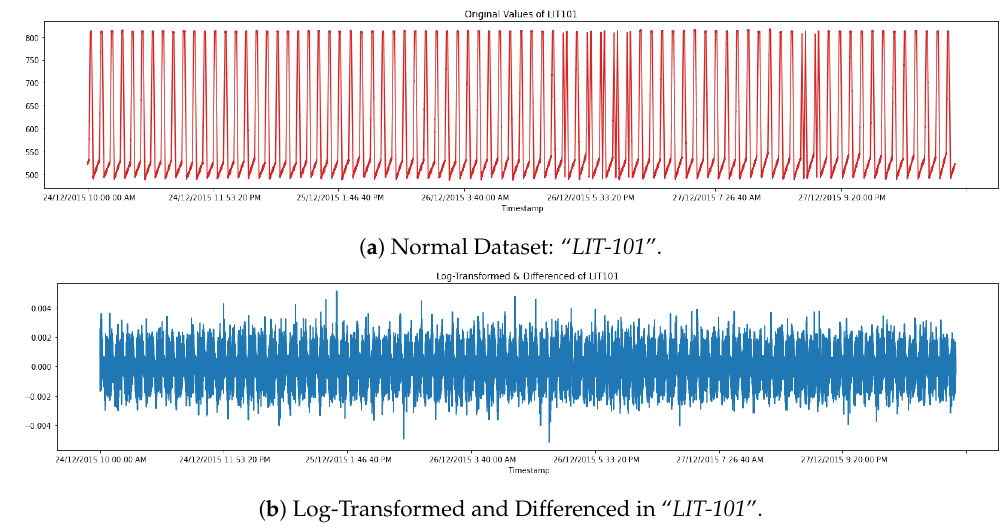
Figure 2. Normal data after removing trend and seasonality “ LIT-101